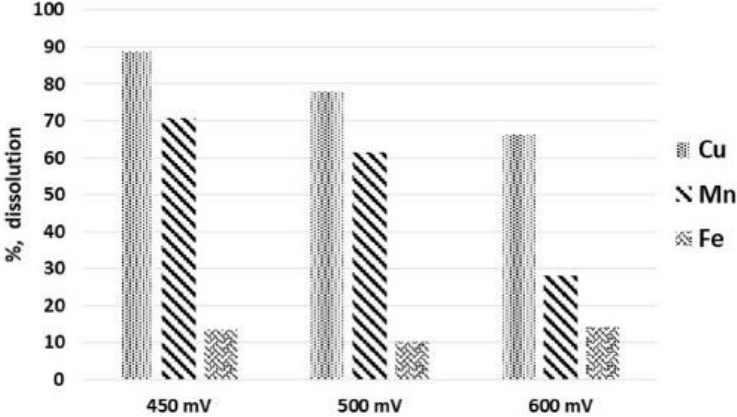
Figure 12. Dissolution of Cu, Mn, and Fe under reducing conditions using FeSO 4 (40 g/L). Solution potential controlled at 450 mV; 500 mV; and 600 mV, at 25 °C and using 50 g/L H 2 SO 4 .